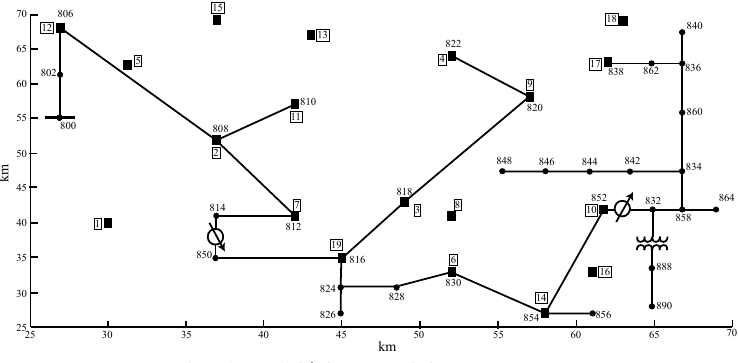
Fig. 1. Pn19k2-IEEE34 test system